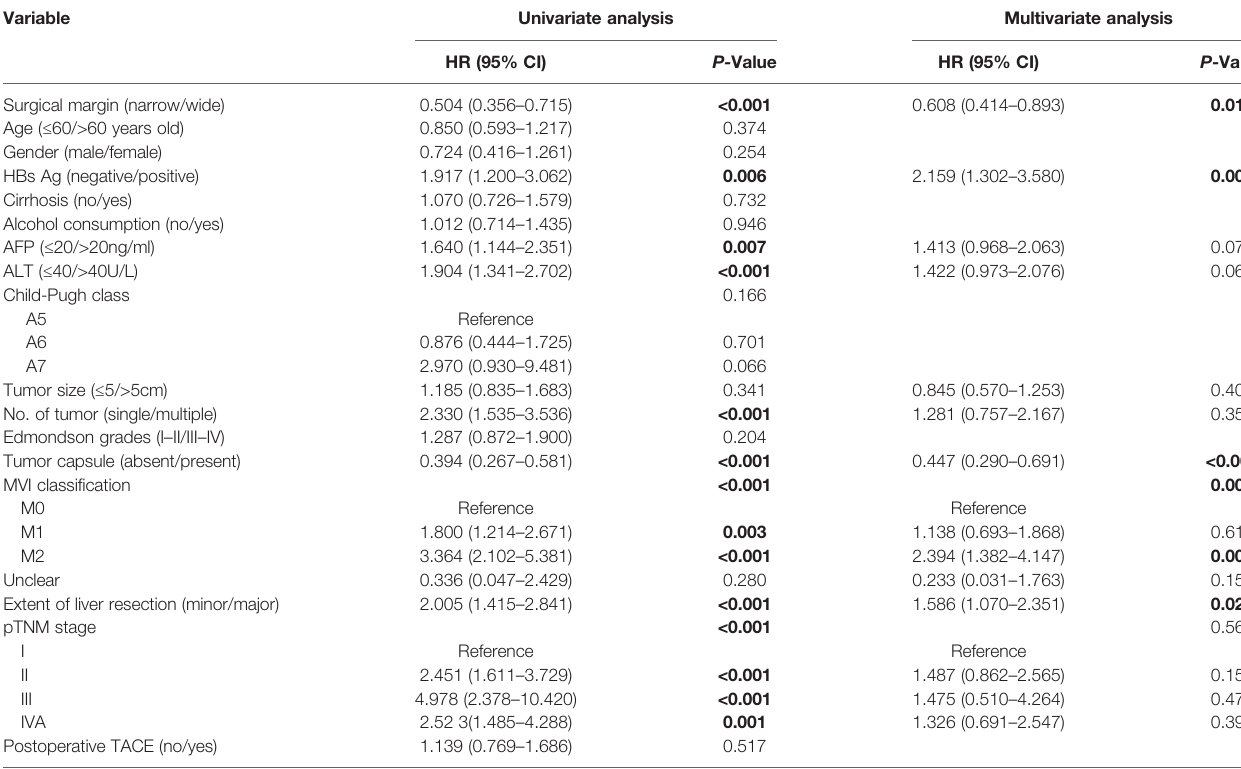
TABLE 3 | Prognostic factors of recurrence-free-survival (RFS) for patients with narrow and wide margin resection. Variable Univariate analysis Multivariate analysis HR (95% CI) P- Value HR (95% CI) P -Value Surgical margin (narrow/wide)